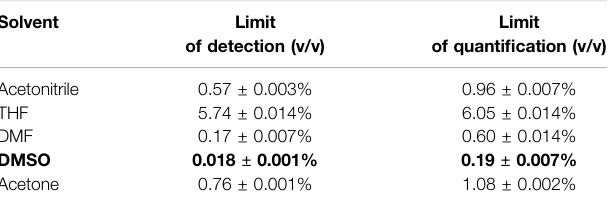
TABLE 1 | Limits of detection and quanti fi cation of water in organic, water- miscible solvents, calculated as the percentage of water by volume. a Solvent Limit Limit of detection (v/v) of quanti fi cation